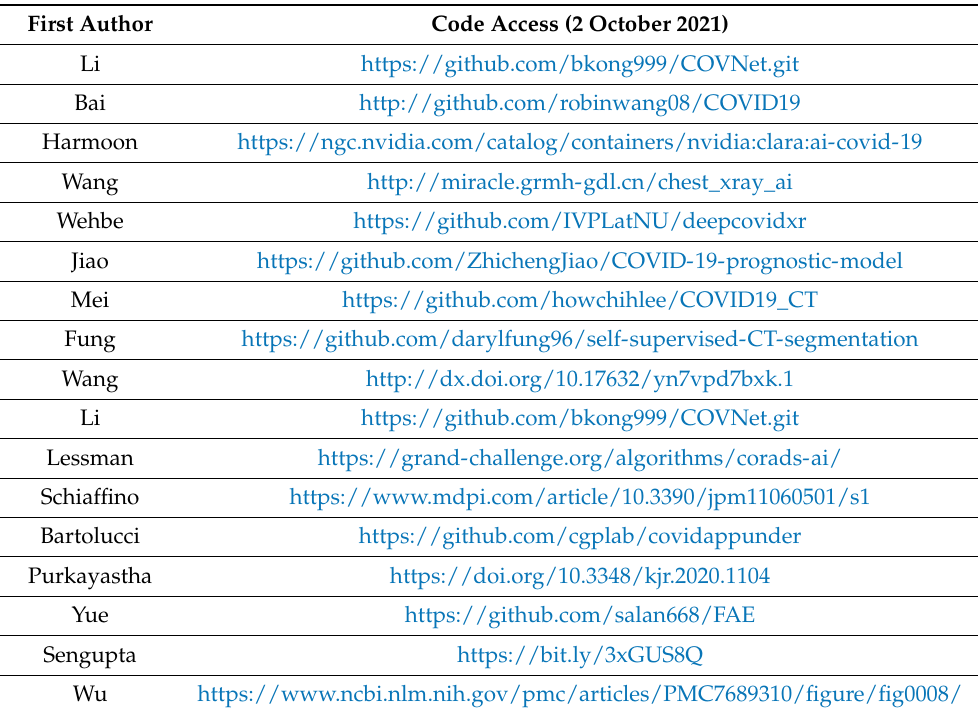
Table A1. Code Access of COVID-19 DL and AI models based on radiology